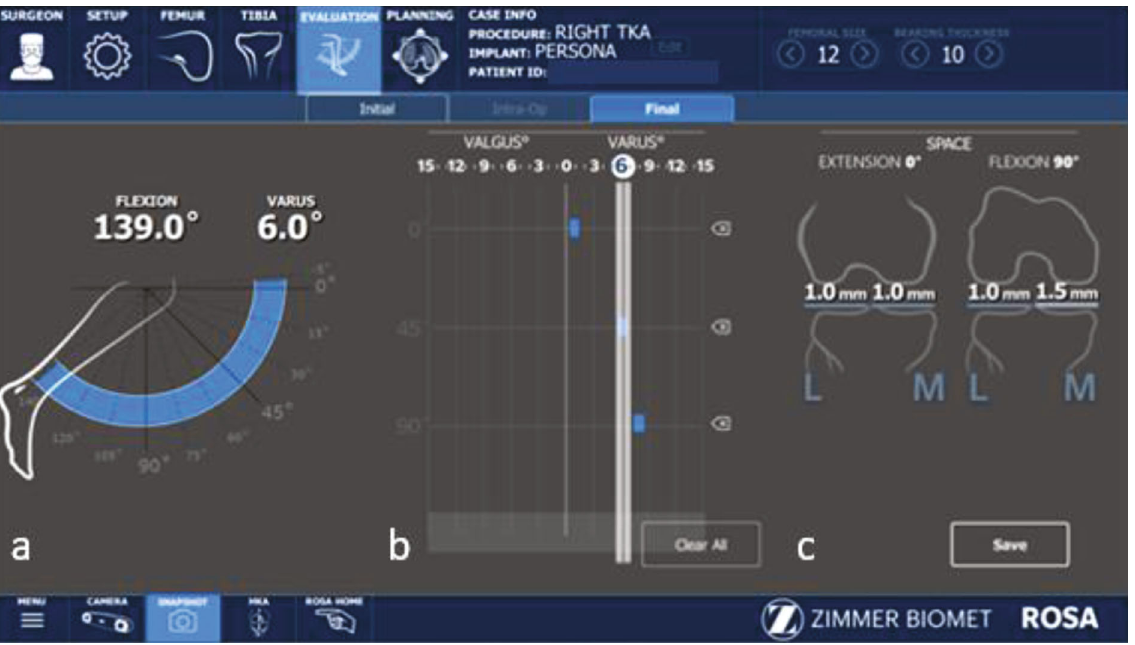
Figure 16: Final evaluation of the knee for Case 4 including (a) ROM, (b) alignment, and (c) joint space